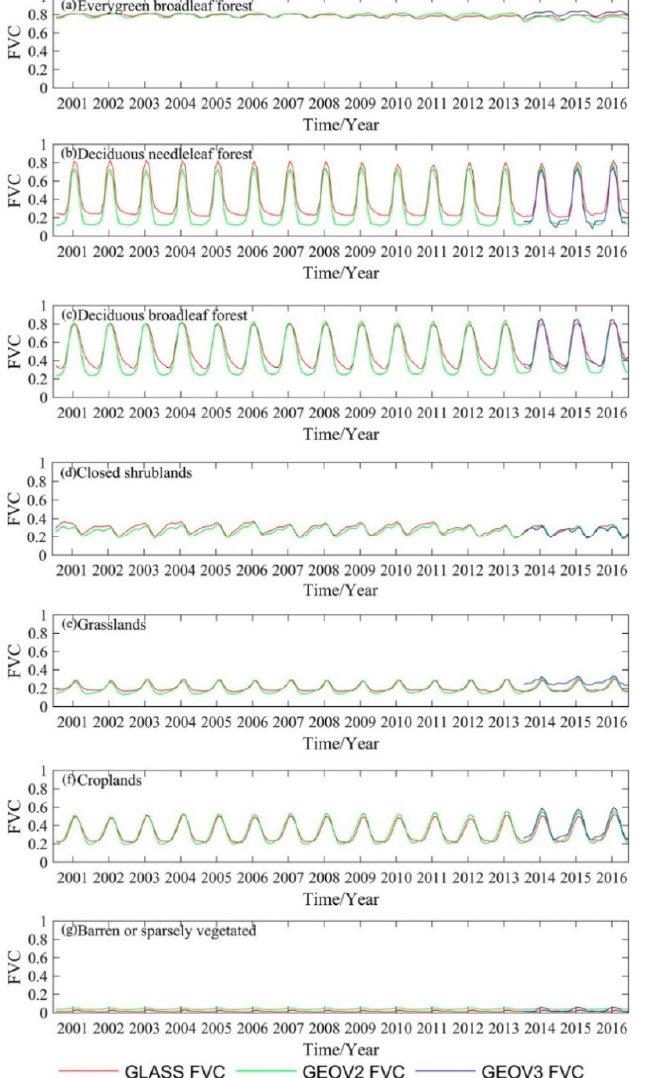
Figure 4. Temporal profiles of mean FVC data for GLASS, GEOV2, and GEOV3 FVC products over different vegetation types.